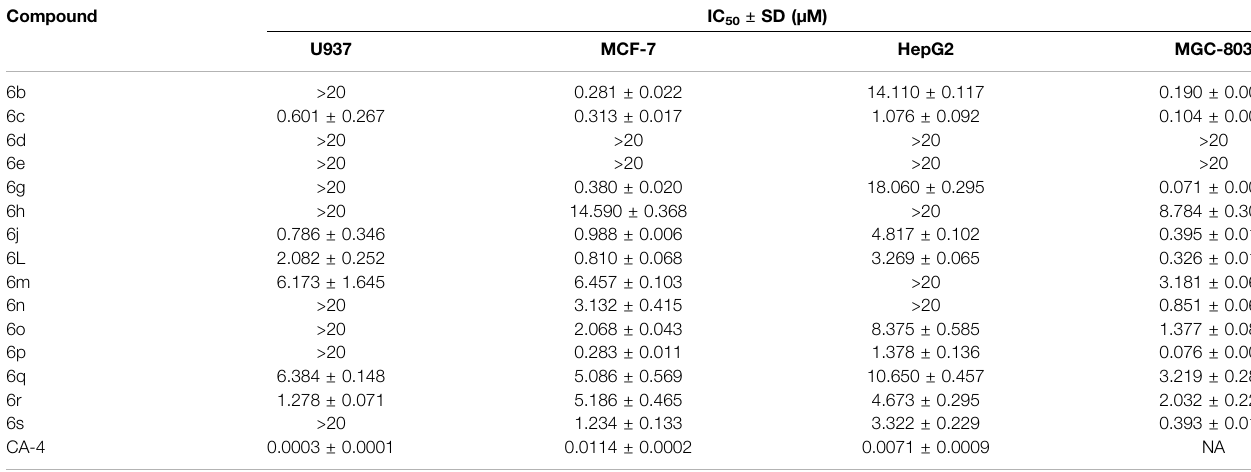
TABLE 1 | Evaluation of in vitro antiproliferative activity of α -unsubstituted chalcones (6) (IC 50a ). Compound